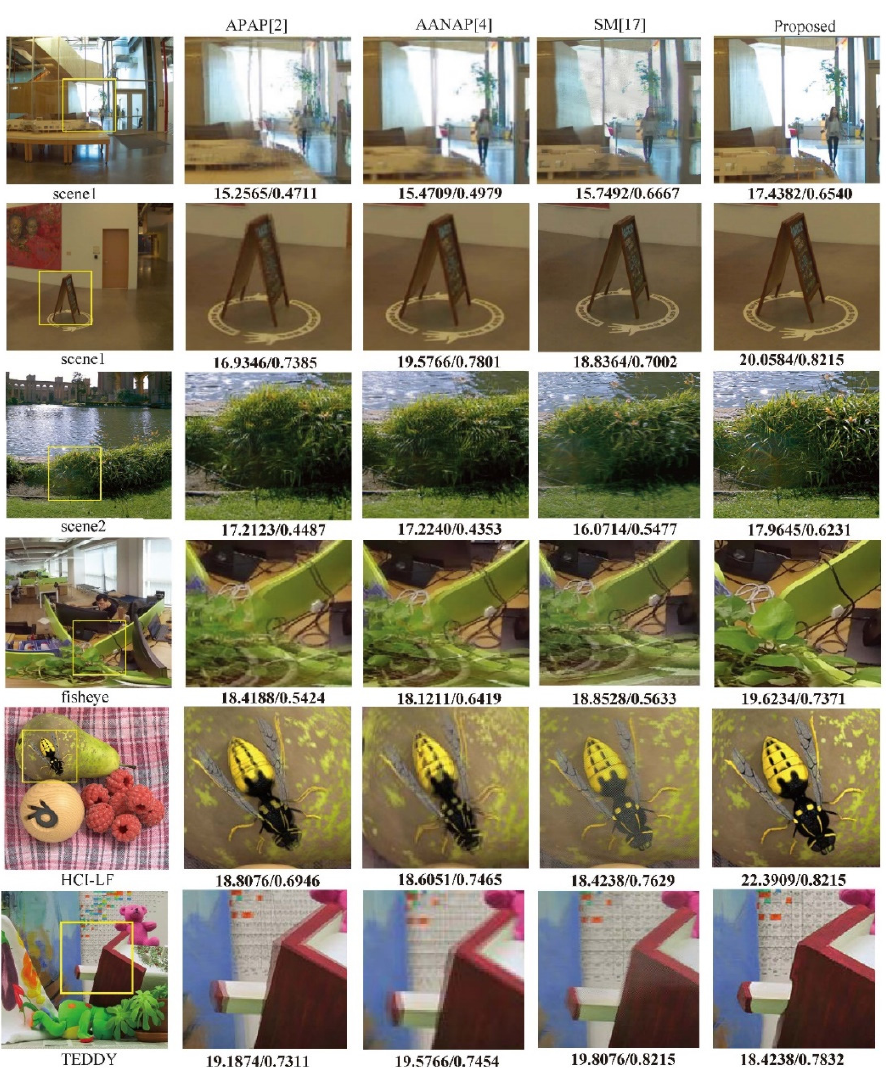
Figure 8. The comparison of the results obtained from other methods proposed for use in several scenes. The values below the images are PSNR and SSIM, respectively. Table 2. MP-PSNR [27], PSNR, and SSIM comparison of the proposed method and [2,4,17]. The bold items indicate which method gets the better performance in each